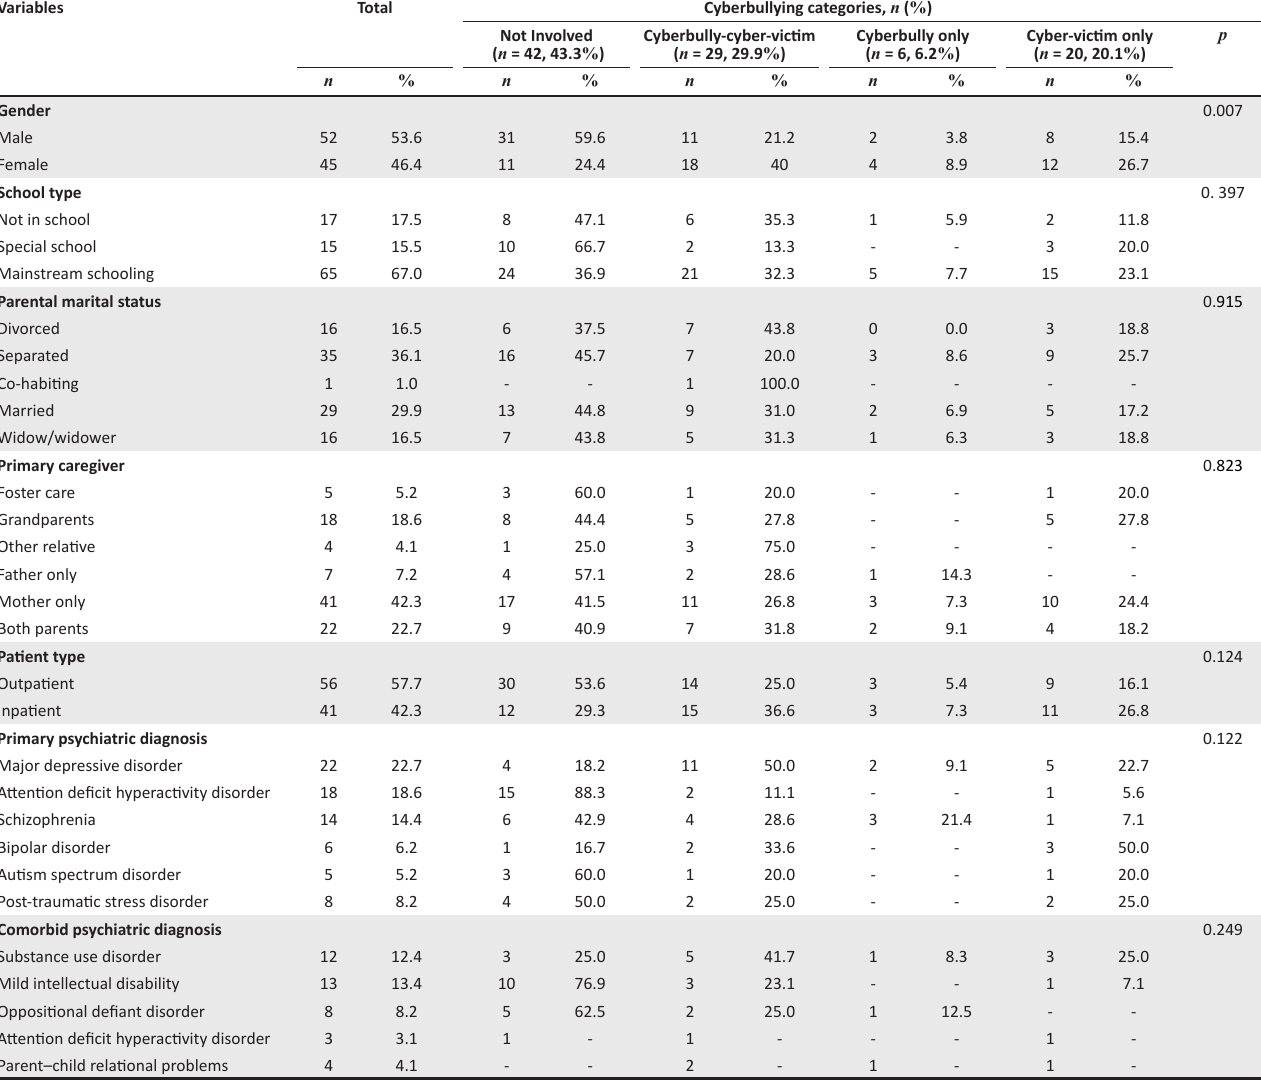
TABLE 1: Demographic and clinical characteristics of participants ( N = 97) showing comparisons between cyberbullying behaviours.